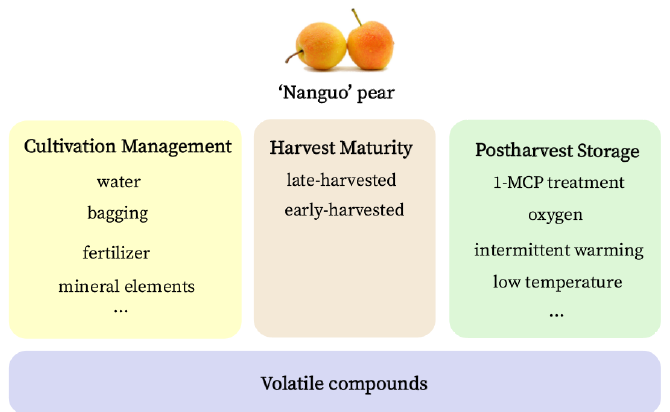
Figure 3. Factors affecting the production of volatile compounds in ‘Nanguo’ pear.